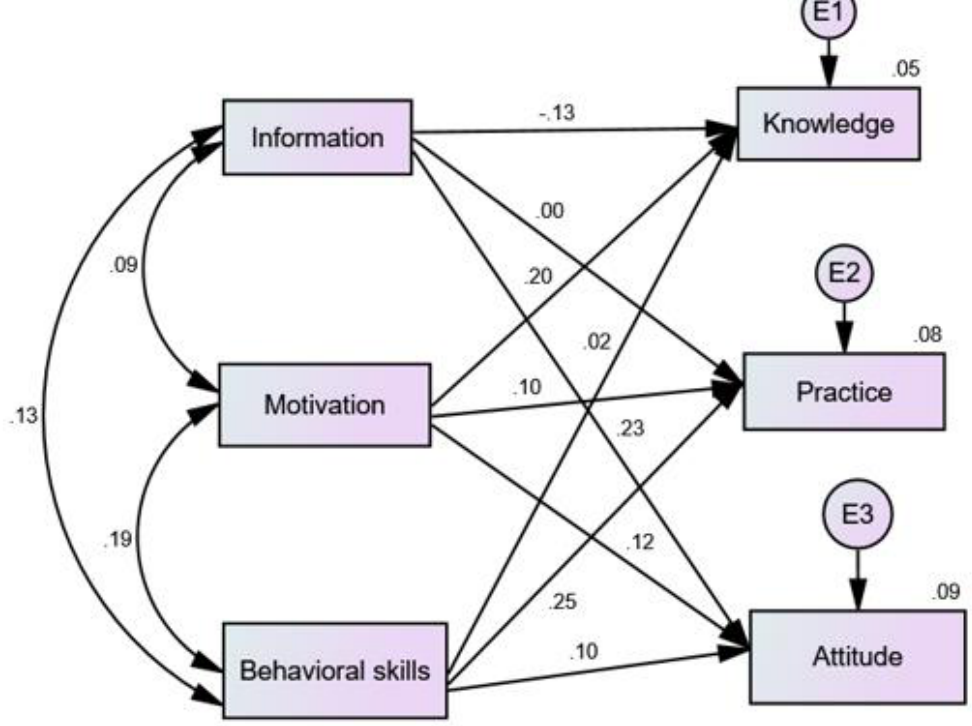
Figure 4. Structural equation model. The measure used in the model: Information; Motivation; Behavioral skills; Knowledge; Attitude; Practice.